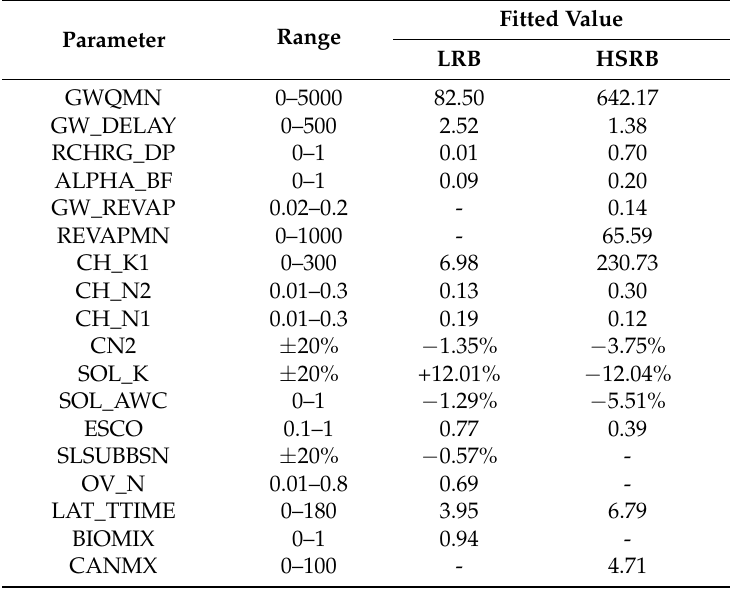
Table 6. Parameters used in the SWAT model calibration in LRB and in